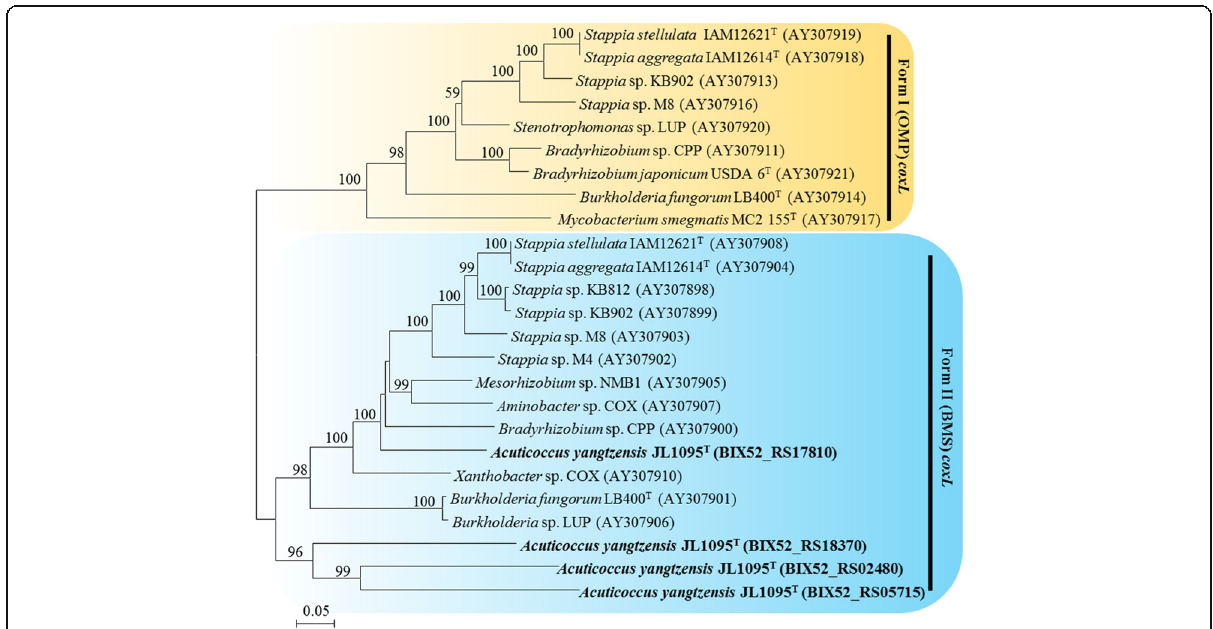
Fig. 3 Unrooted phylogenetic tree showing the coxL genetype of Acuticoccus yangtzensis JL1095 T . The tree was constructed with MEGA 5.05 software by using the neighbor-joining (NJ) method based on the form I coxL and form II putative coxL genes from CO-oxidizing microbes. Accession numbers in the GenBank database are shown in parentheses. The coxL genes encoded in the Acuticoccus yangtzensis JL1095 T genome are shown in bold. Sequences in orange and blue shades represent form I and II coxL genes, respectively. The numbers at the nodes indicate bootstrap percentages based on 1000 replicates; only values higher than 50% are shown. Bar, 0.05 substitutions per nucleotide